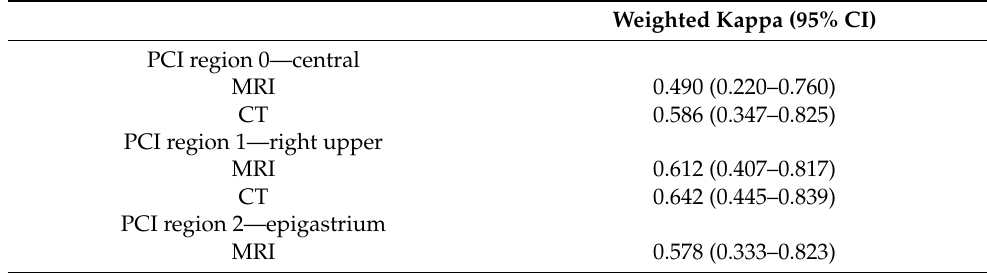
Figure 2. Agreement between imaging and intra-operative total peritoneal cancer index score. Scatterplot of ( a ) MRI and ( b ) CT against intra-operative score. Scatterplot of difference from intra-operative score for ( c ) MRI and ( d ) CT. Percentage change of ( e ) MRI and ( f ) CT score from intra-operative score by individual patients with 10% accuracy bound. p -values in ( b , c ) were based on paired t -test, testing whether mean differences were different from zero. Table 2. Agreement between imaging scan and intra-operative PCI score by PCI